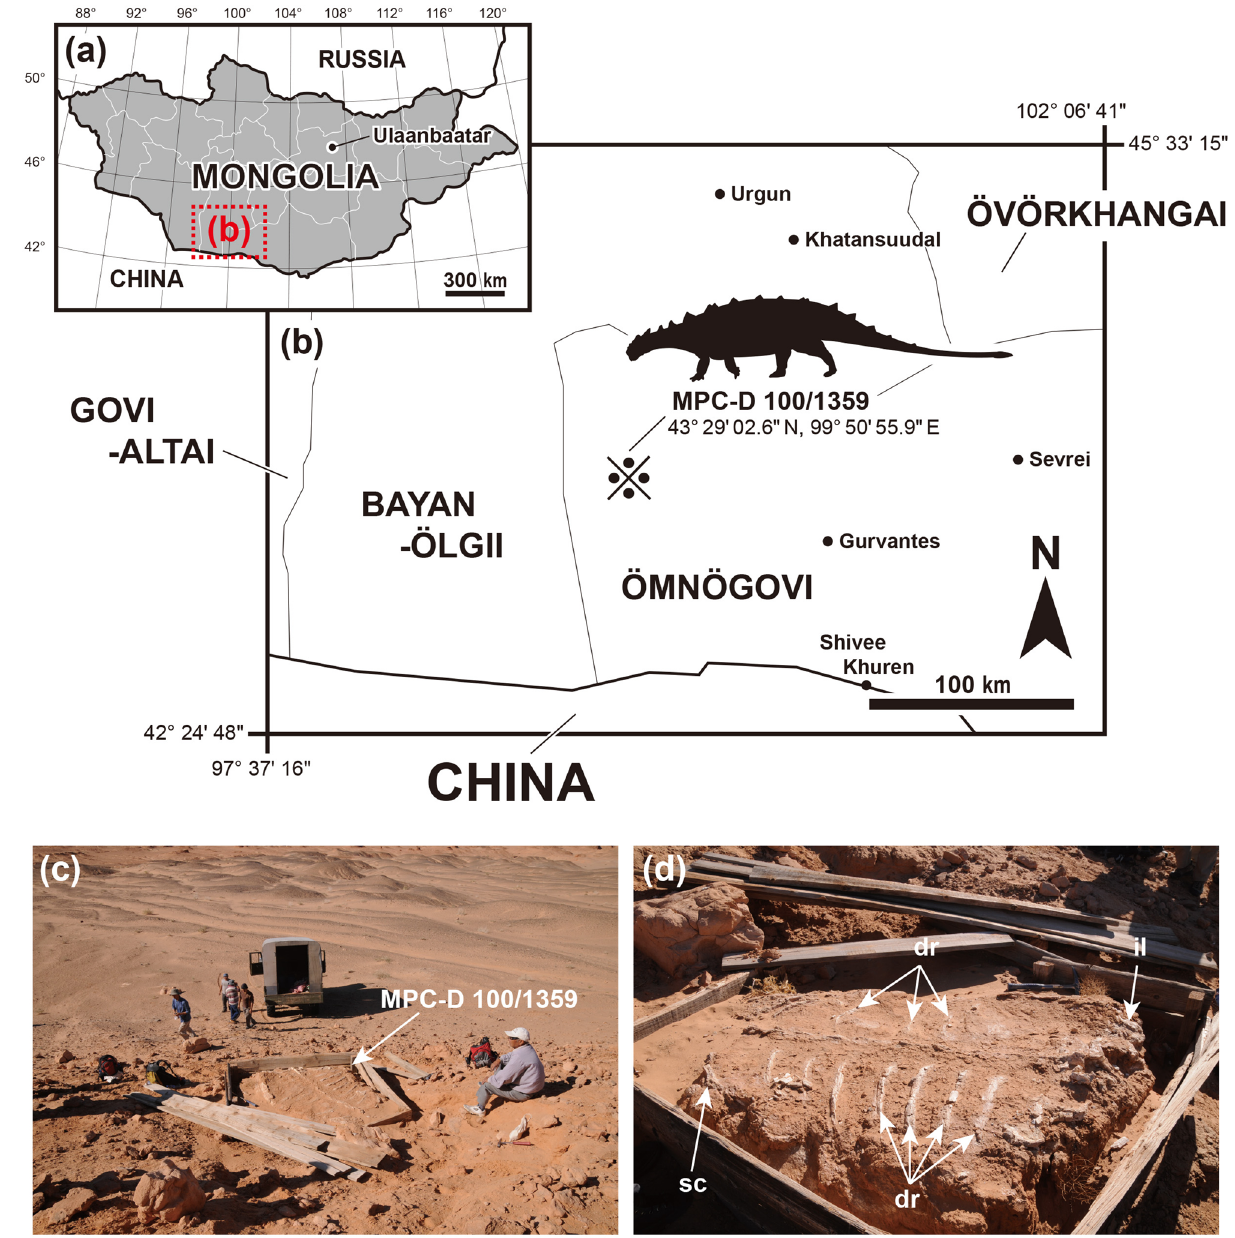
Figure 1. Map showing where the new ankylosaurid postcranial specimen (MPC-D 100/1359) was discovered. ( a ) Map of Mongolia. ( b ) Enlarged map of the rectangle with the dotted line in ( a ). The fossil locality is marked by a symbol ( ). ( c ) Photograph of the excavation site. ( d ) Close up photograph of the exposed dorsal surface of the specimen. Adobe Illustrator CC (version 24.0.1, https ://www.adobe .com/kr/produ cts/illus trato r.html) was ※ employed to produce ( a , b